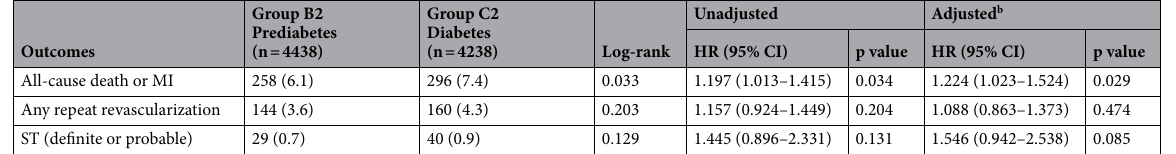
Table 3. Two-year clinical outcomes according to the different glycemic status. POCOs patient-oriented composite outcomes defined as a composite of all-cause deaths, Re-MI or any repeat revascularization,